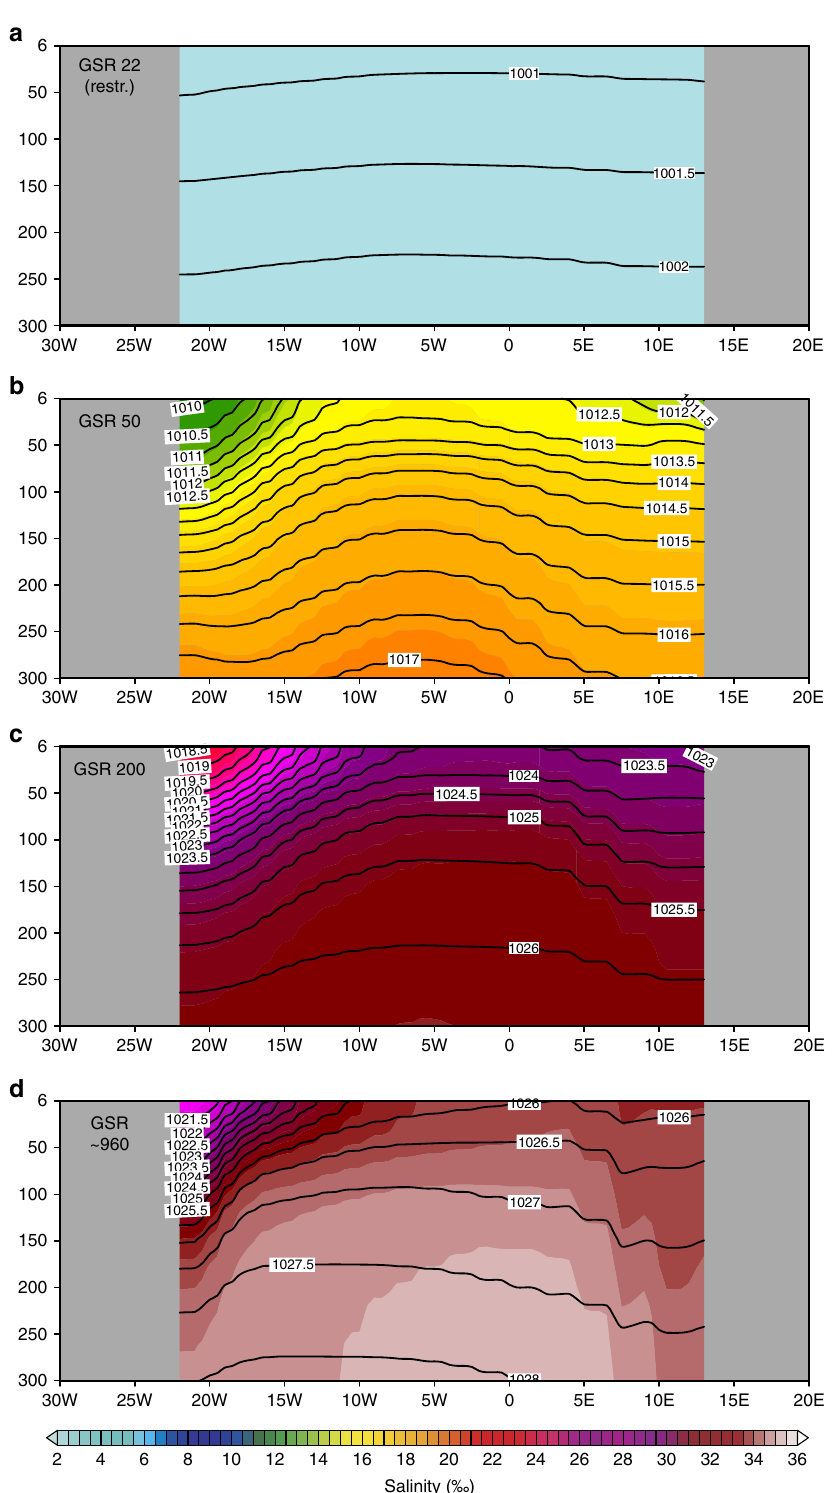
Figure 5 | Evolution of the subpolar Arctic gyre from restricted freshwater conditions towards a brackish and modern prototype salinity distribution. Zonal section at B 70 (cid:2) N across the subpolar Arctic (Greenland and Norwegian Seas) gyre displays the salinity (colour coded; % ) and pressure (contour lines; Pa) evolution from ( a ) a restricted (sill depth at 22m) to ( b ) semi-enclosed estuarine (GSR sill depth at 50m) and ( c ) bi-directional (sill depth at 200m) to ( d ) modern prototype circulation regime (sill depth at ca. 960m) across the Greenland-Scotland Ridge gateway. NATURE COMMUNICATIONS|8:15681|DOI: